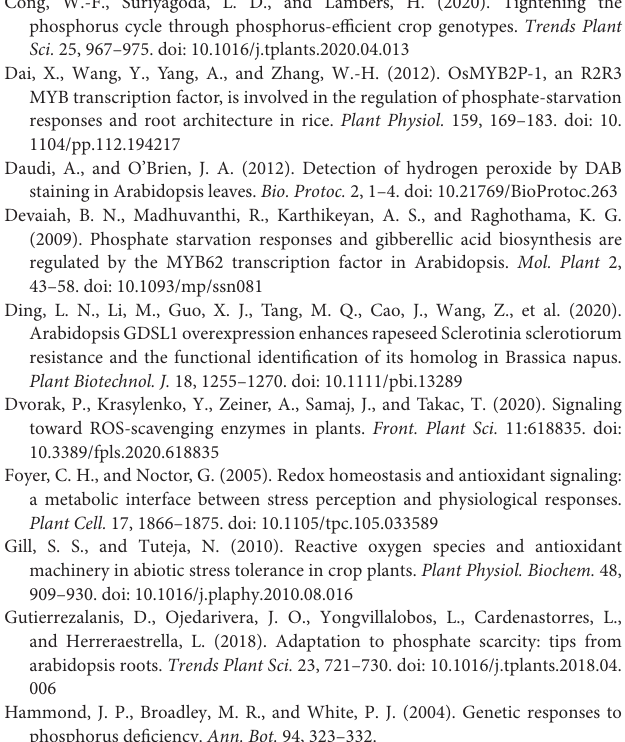
Supplementary Figure 1 | Expression levels of Gm6PGDH1 in hairy roots of soybean composite plants. Supplementary Figure 2 | Expression levels of several GmPAP genes in Gm6PGDH1 -overexpressing composite soybean plants. Supplementary Figure 3 | The Gm6PGDH1 -overexpressing transgenic soybean was identified by PCR and quantitative real-time PCR (RT-qPCR). Supplementary Figure 4 | Root activity was detected by trypan blue staining. Supplementary Figure 5 | Silencing Gm6PGDH1 had no effect on tolerance to phosphate starvation in soybean. Supplementary Figure 6 | The Gm6PGDH1 -overexpressing transgenic Arabidopsis was identified by PCR and RT-qPCR. Supplementary Table 1 | Primer sequences were used for vector construction and detection. Supplementary Table 2 | Primer sequences for qRT-PCR analysis in soybean. Supplementary Table 3 | Primer sequences for qRT-PCR analysis in Arabidopsis